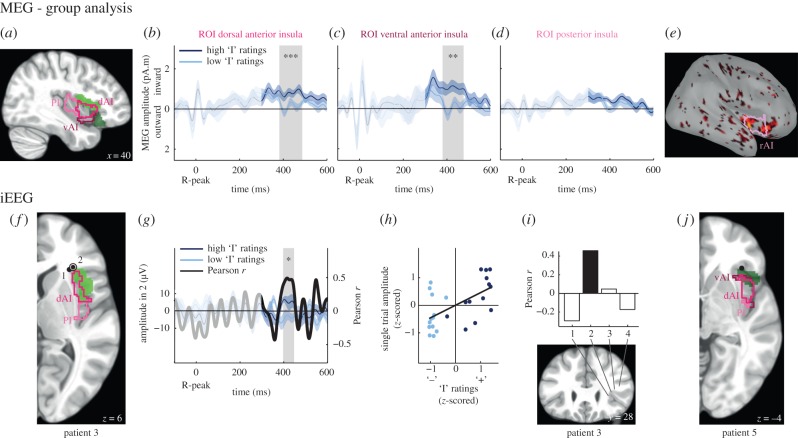
The amplitude of HERs in the rAI correlates with the involvement of the ‘I’ in spontaneous thoughts, in MEG (panels a–e) and in iEEG (panels f–j). (a) Sagittal view of the insula with three insular sub-regions [30] highlighted: PI (light pink), dAI (pink), vAI (dark pink). Light green and dark green regions are associated with parasympathetic and sympathetic regulation respectively [34]. (b–d) Time course of the HER (±s.e.m. across the 16 participants) for ‘high’ and ‘low’ responses on the ‘I’ scale (median split of responses), for the three ROIs in MEG source analysis. The grey area highlights the time window where a significant difference between HERs for ‘high’ and ‘low’ ratings on the ‘I’ scale was observed. (e) Differential MEG source activity for ‘high’ versus ‘low’ ratings on the ‘I’ scale averaged over 384–480 ms post R-peak (threshold for visualization: uncorrected p < 0.05; 75% smoothness applied to the cortical surface). The pink region corresponds to the rAI (union of dAI and vAI). (f) Axial view of the right hemisphere showing the PI (light pink) and dAI (pink). Black dots correspond to the two recording sites analysed in patient 3. Recording site 2 (circled dot) showed a significant correlation between HER amplitude and ‘I’ ratings, in a time window consistent with the MEG results. Areas in green are involved in parasympathetic regulation [34]. (g) Time course of the trial-by-trial Pearson correlation coefficient r between HER amplitude and ‘I’ ratings (black), and HERs (±s.e.m) for ‘high’ (dark blue) and ‘low’ (light blue) ratings on the ‘I’ scale (median split of responses), for recording site 2 of patient 3 (circled dot in f). The grey area highlights the time window in which a significant correlation between HER amplitude and ‘I’ ratings was observed. (h) HER amplitude in the significant time window plotted against ‘I’ ratings. Each point represents one trial. (i) Mean Pearson correlation coefficient in the 397–443 ms time window, along the different recording sites of the electrode shaft of patient 3. (j) Axial view of the right hemisphere showing the PI (light pink) and dAI (pink), for patient 5. The black dot corresponds to the recording site analysed for this patient, where no significant correlation was observed.